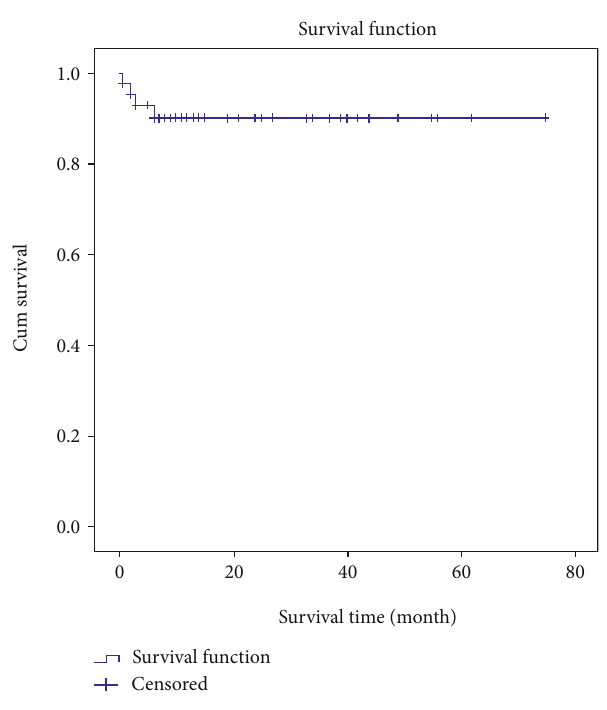
Figure 5: Survival of patients during the study follow-up